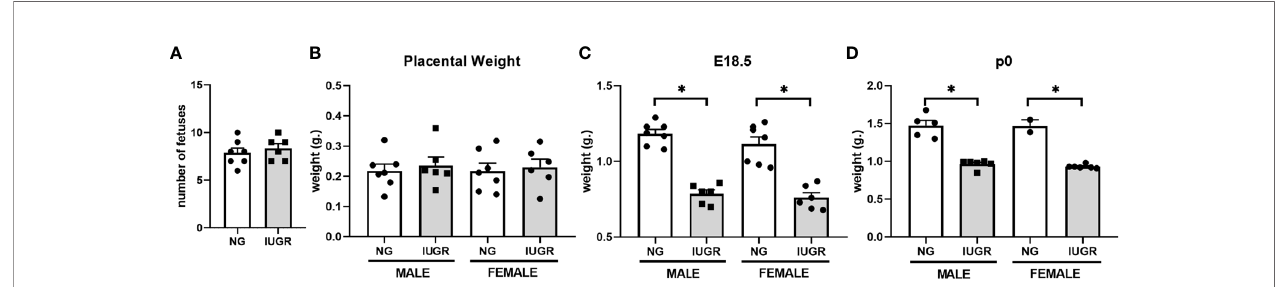
FIGURE 2 | Intra-uterine growth restriction (IUGR) decreases fetal and neonatal weight. Fetal male and female (A) number, and average (B) placental weight, and (C) body weight were measured at E18.5. Each dot represents the mean per litter. (D) Neonatal male and female body weights were measured at P0. * P <0.05 vs . IUGR by Student ’ s t test. Values are represented as means